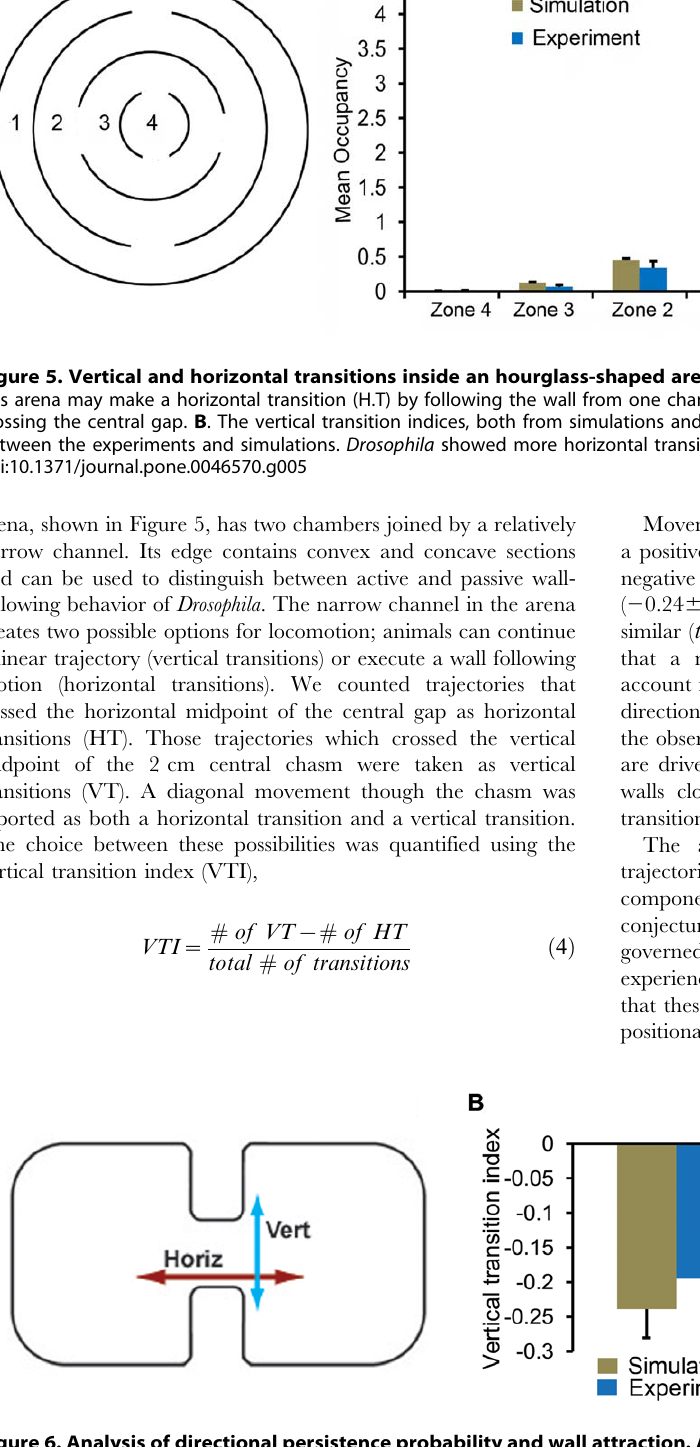
Figure 6. Analysis of directional persistence probability and wall attraction. A . P ( r , h ) in the central zone of a circular arena of radius 4.2 cm is shown. P ( r , h ) was computed with a bin size of 0.18 cm along r and 6 o along h . A cell in the two dimensional plot represents a pair of r and h . B . P ( r , h ) in the central zone of a circular arena of radius 2.5 cm is shown. The trajectories of the fly in the central zone of the two circular arenas were similar. C . P ( h D r ) in the central zone of radius 4.2 cm arena. To obtain P ( h D r ) for r ~ r o , portions of the trajectories with radial displacements, r ~ r o + 0 : 02 , cm were considered. D . P ( r D h ) in the central zone of radius 4.2 cm arena. To obtain P ( r D h ) for h ~ h o , portions of the trajectories with angular displacements, h ~ h o + 6 o , were considered. E . Radial distribution of a wild type fly and simulations, with F o ~ 0 : 0268 cm s { 1 , in the circular arena of radius 4.2 cm. The radial distribution from the simulations with F o ~ 0 : 0268 cm s { 1 was closest to that of Drosophila